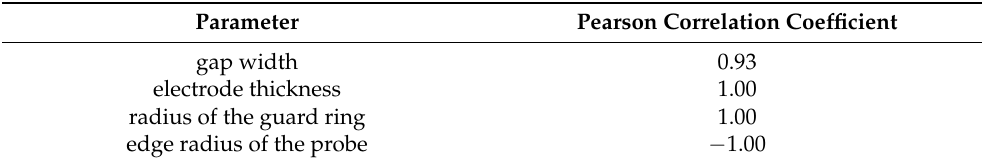
Table 3. Pearson correlation coefficients of slope error and nonlinearity depending on the sensor